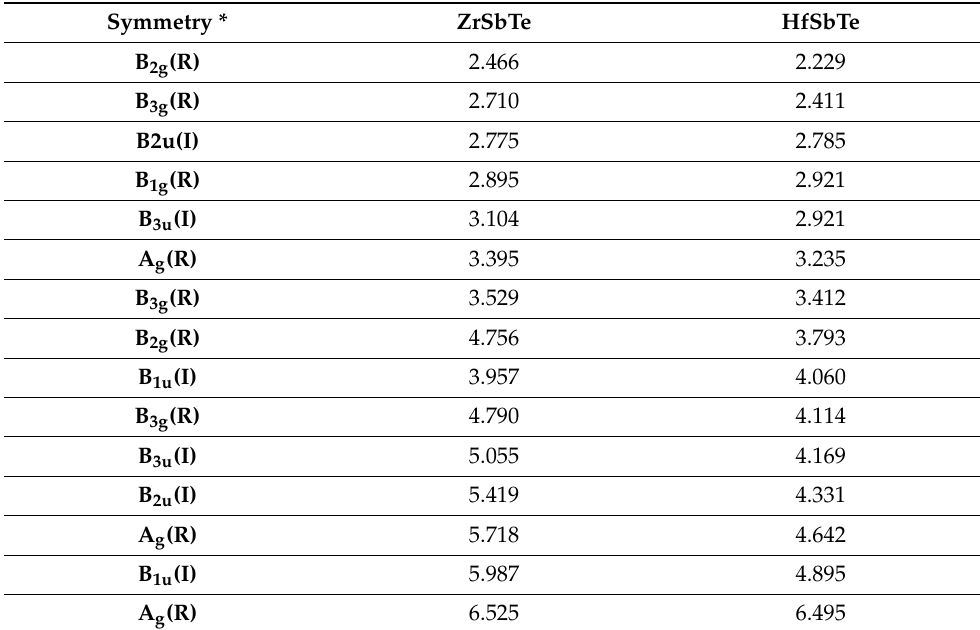
Table 1. Phonon frequencies (THz) at Γ point: * (R): Raman Active; (I): Infrared Active. Symmetry *